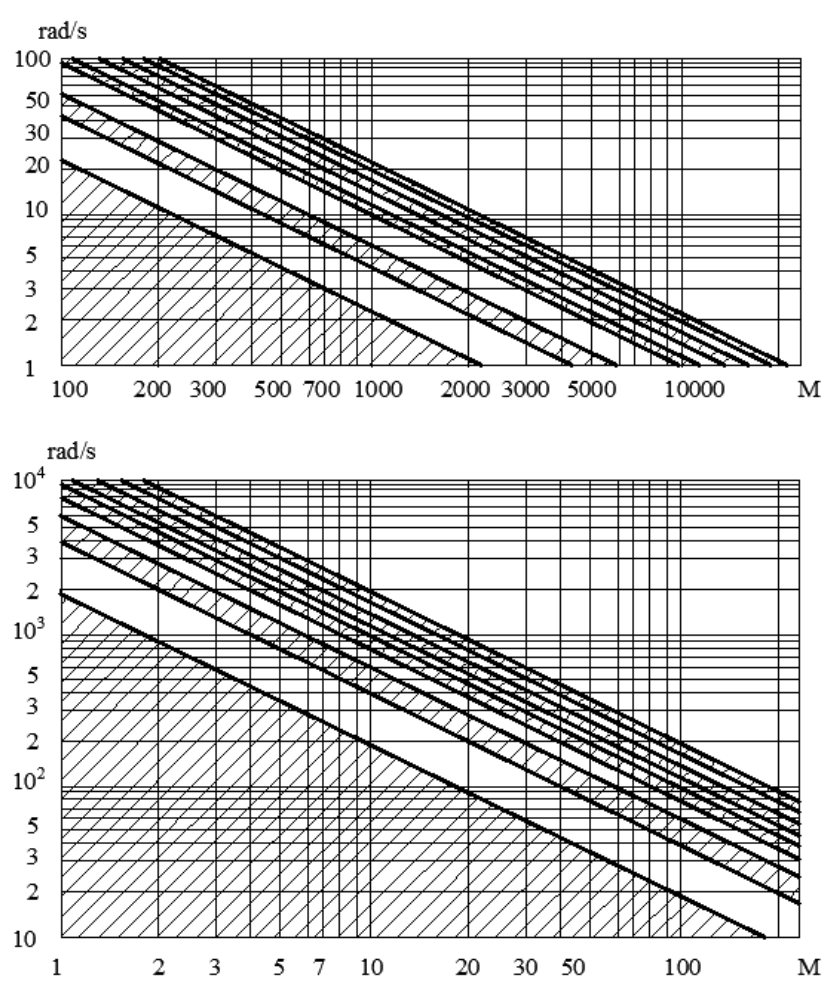
Fig. 4. Calculated stability regions (shaded) and instabilities for volumetric hydraulic